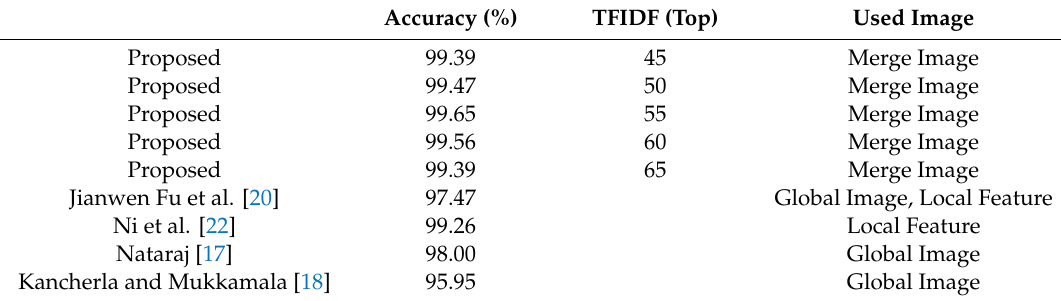
Table 3. Comparison between proposed method and related work.